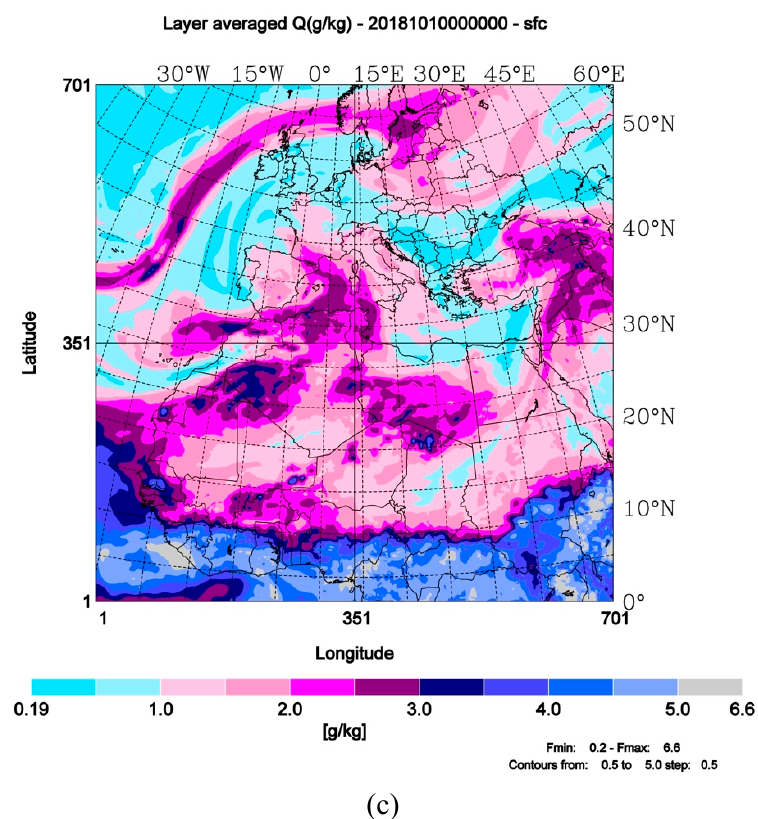
Figure 2. ( a ) Equivalent potential temperature (filled contours, (K)), sea surface pressure (contours, (hPa)), and wind vector (one arrow every 15 grid points in both directions, maximum value 16 m/s) at 12 UTC (Universal Coordinated Time) on 10 October 2018; ( b ) geopotential height (filled contours, (gpm)), temperature (contours, (K)) and wind vectors (one arrow every 15 grid points in both directions, maximum value 28.8 m/s) at 12 UTC on 10 October 2018; ( c ) averaged water vapor mixing ratio between 3 and 10 km height at 00 UTC on 10 October 2018. The labels along the bottom x-axis and the left y-axis show the grid-point number.